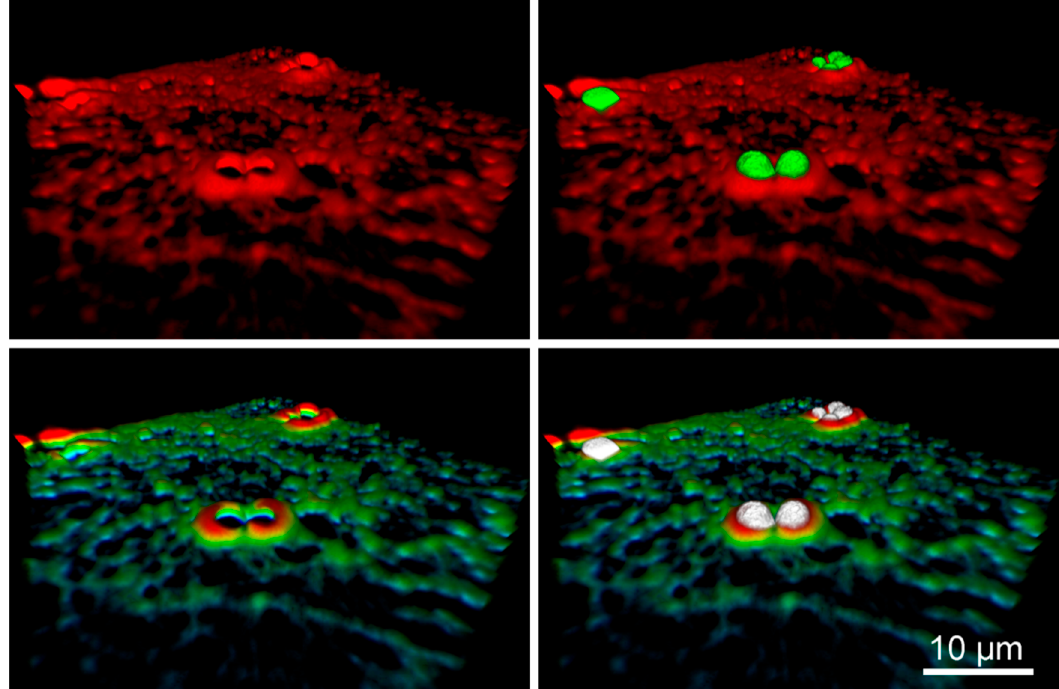
Figure 4. The microtubule cup-like structure in 3D rendering. The part of the same cell as in Figure 3D is shown. ( upper panels ) A 3D visualization of microtubule surface (red) surrounding beads (green). ( lower panels ) The height-color-coding for the same fragment for microtubule filaments (blue → green → yellow → red: low → high). Beads are shown in white. Images were rendered using FluoRender; rendering parameters in Supplementary Note S1.